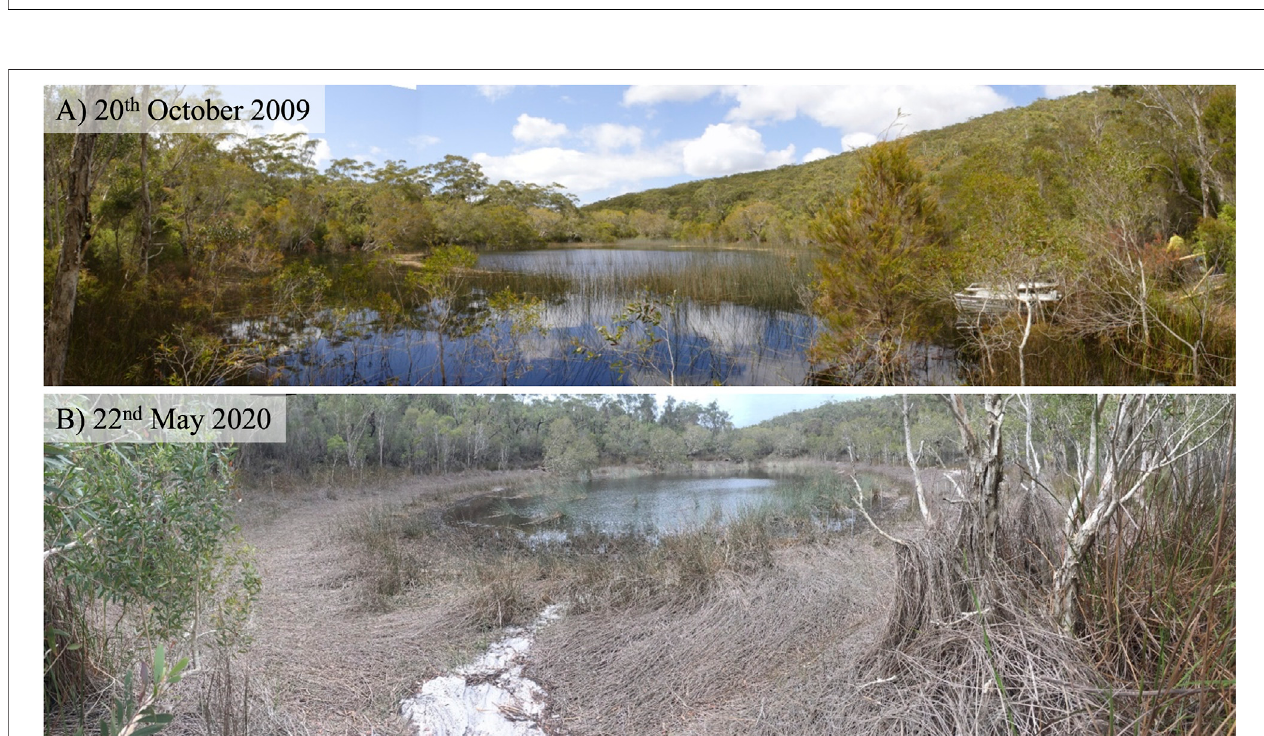
FIGURE 2 | Photographs of Swallow Lagoon taken at the same location in (A) 20 October 2009 and (B) 22 May 2020 demonstrating variability in wetland water level.